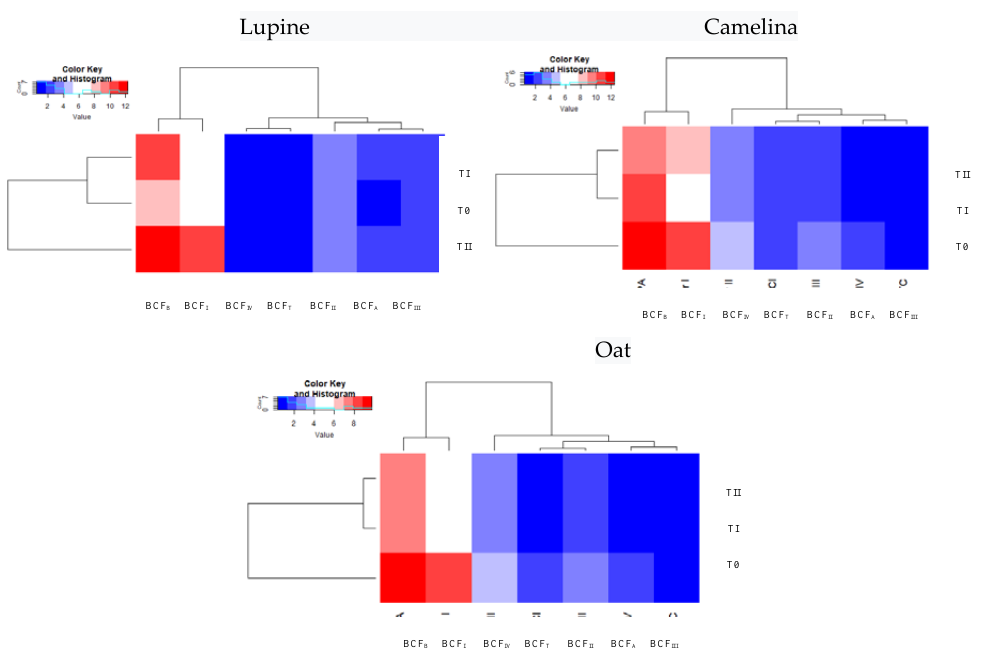
Figure 6. The heat maps for the nickel bioconcentration in cultivated plants (lupine, camelina, and oat) in dependence on treatments (T0, TI, TII).